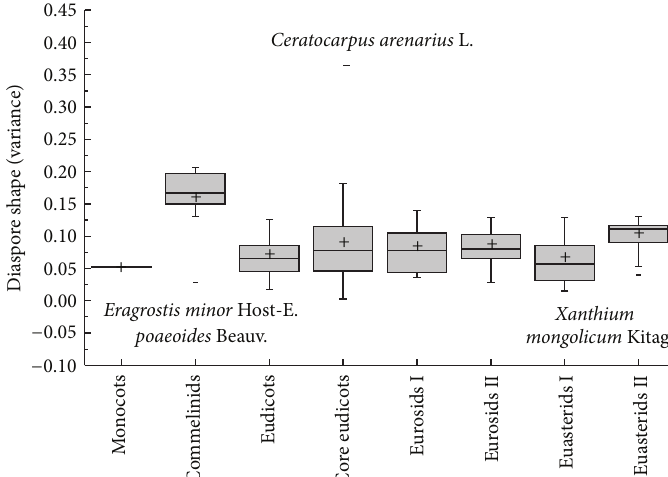
Figure 5: Box plots showing mean (+), median (—), quartiles, and outliers (-) of diaspore shape (variance) of 150 species grouped by different APG II taxonomic phylogeny group. Because Coniferopsida and Rosids are only one species, they do not compare with others.